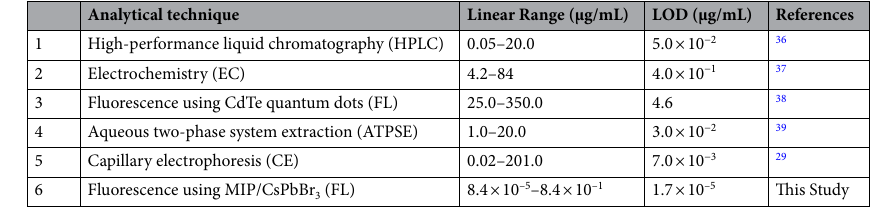
Table 2. Comparison of CsPbBr 3 -loaded MIP nanogels with other general methods for the detection of ROX.